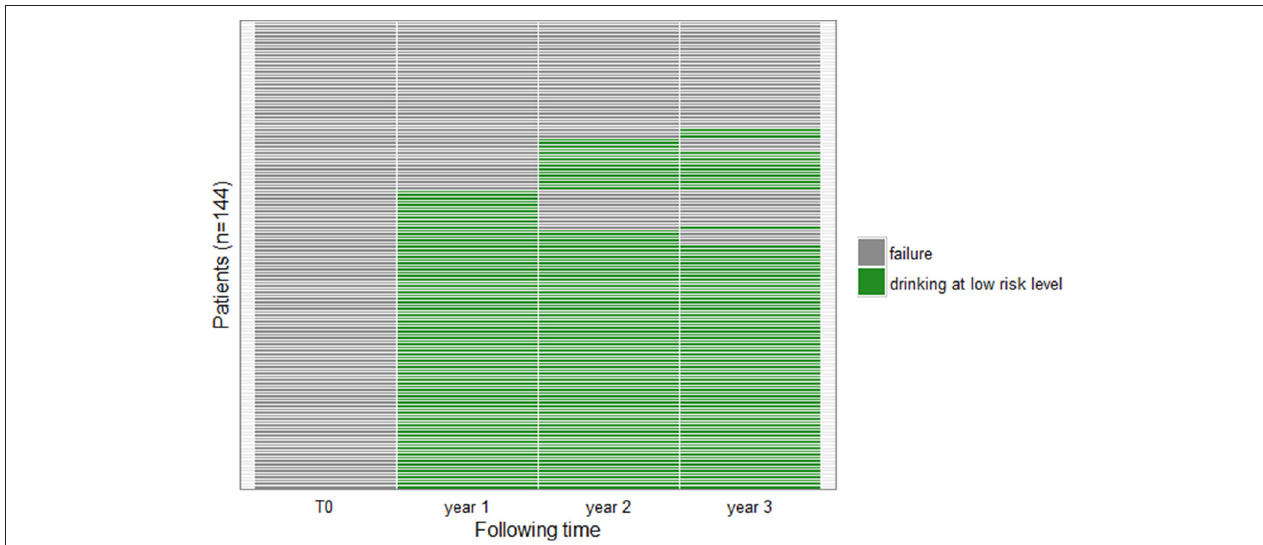
FIGURE 1 | Patient outcomes during follow-up. Each row corresponds to one patient. The colors correspond to drinking levels for patients at 3 follow-up visits (year 1, year 2, year 3): green: abstinent or low-risk drinkers; gray: failure.